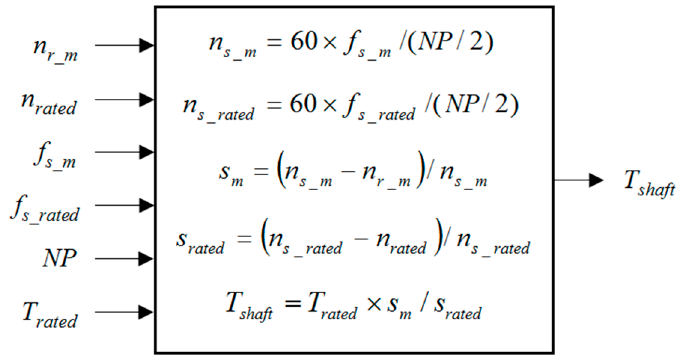
Figure 7. Slip method procedure.